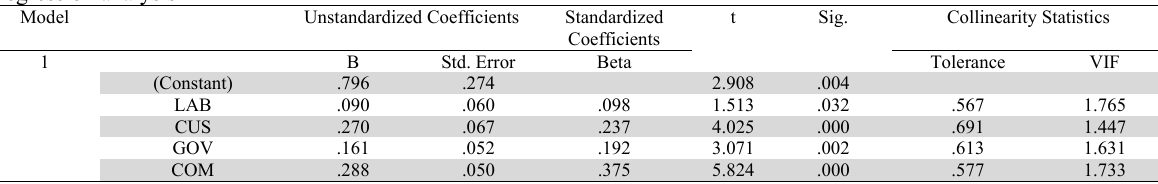
Regression analysis